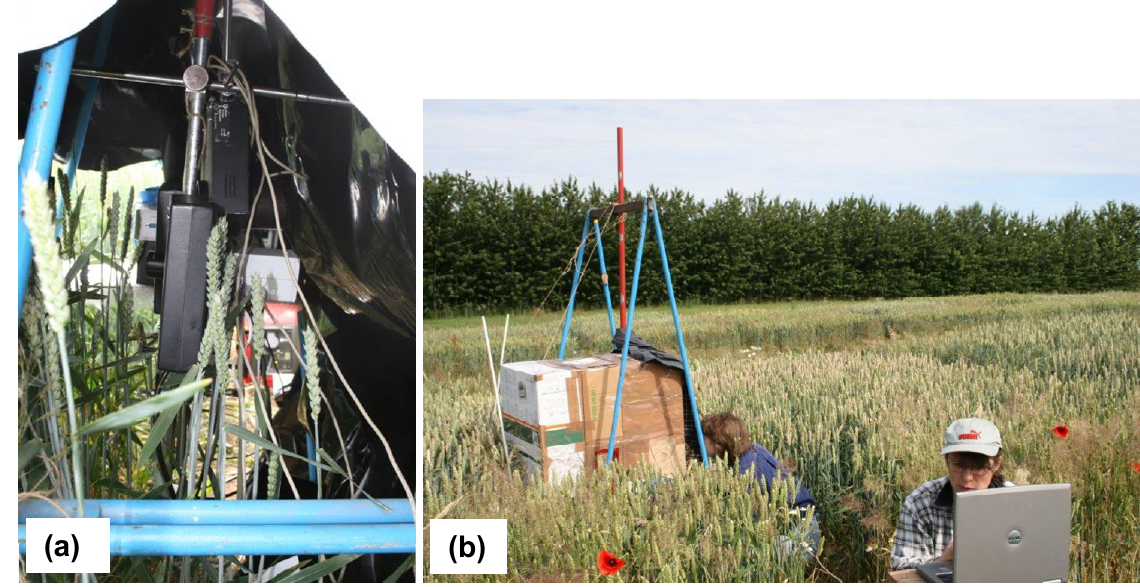
Figure 4. Images of F